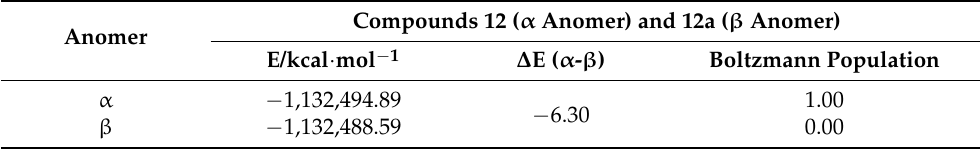
Table 2. Energy difference between the α and the β anomers for compound 12 .